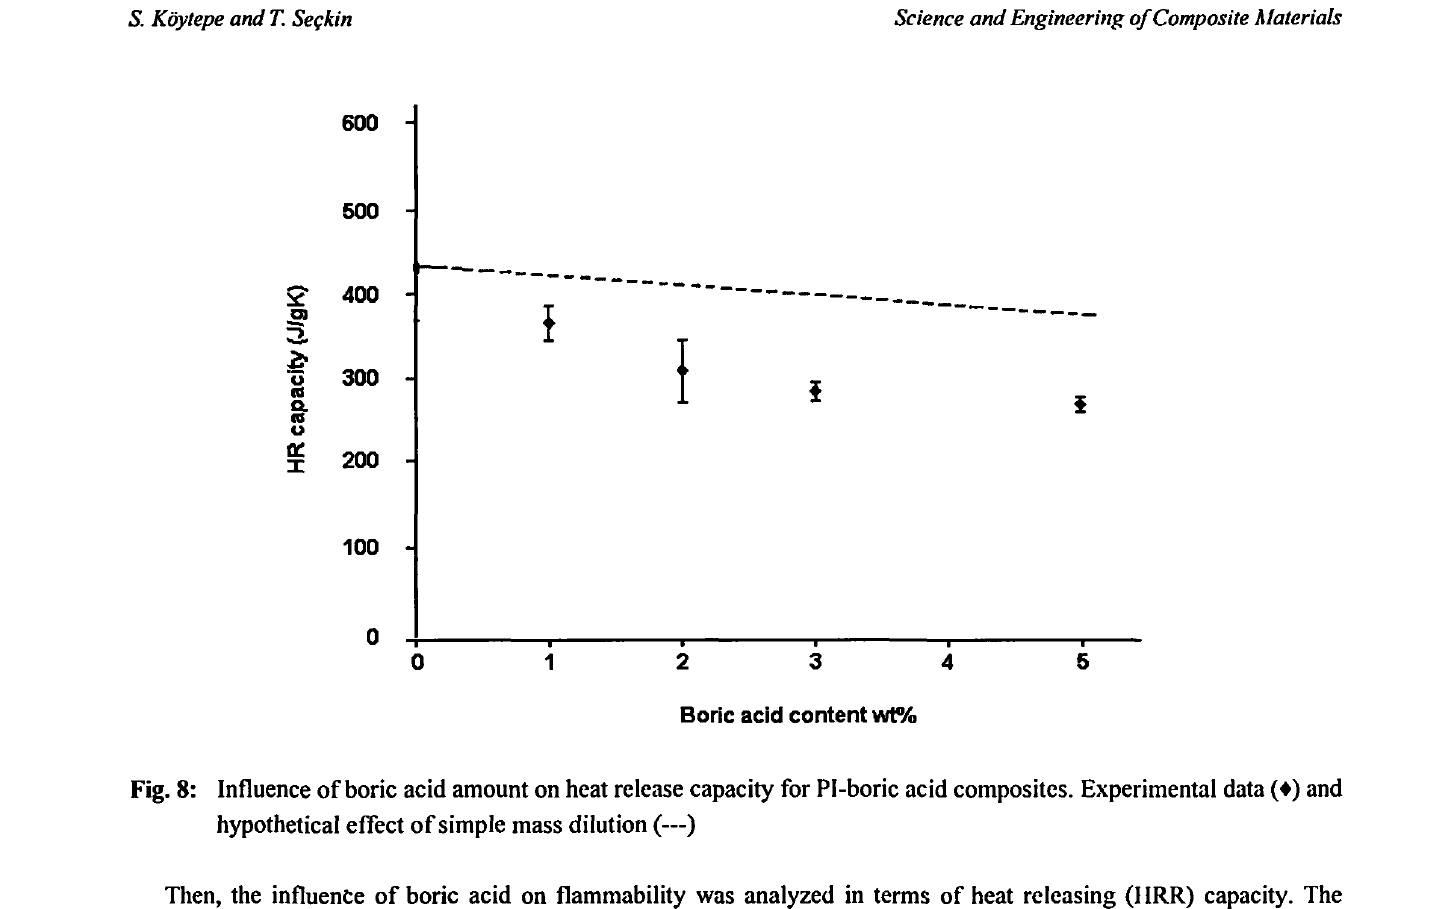
Fig. 8: Influence of boric acid amount on heat release capacity for Pi-boric acid composites. Experimental data (») and hypothetical effect of simple mass dilution